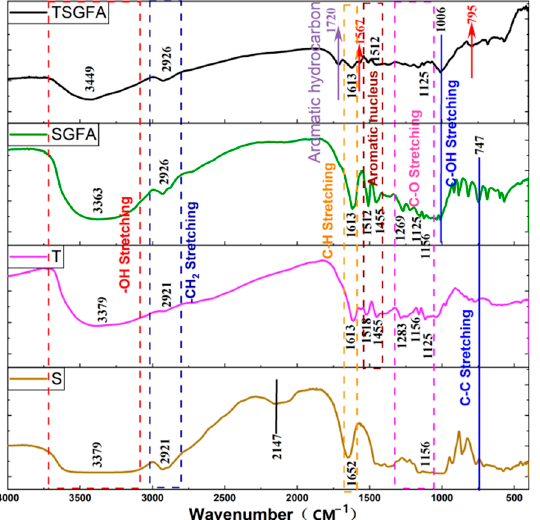
Figure 1. FTIR spectra of starch (S)-, tannin (T)-, tannin–starch–glyoxal–furfuryl alcohol (SGFA)-,